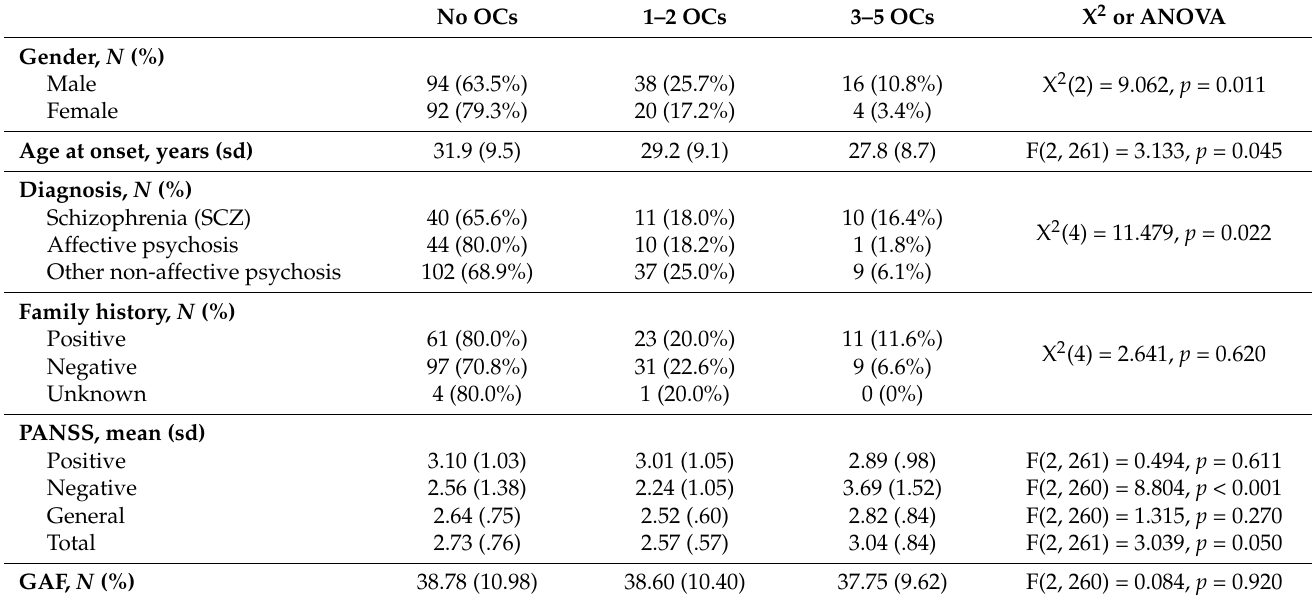
Table 1. Demographic and clinical differences across patients with increasing numbers of OCs ( N = 264). X 2 (df), p stays for the Chi-square test (degree of freedom) with its p -value; F(df1,df2), p stays for the F test (numerator degree of freedom, denominator degree of freedom) with its p -value.